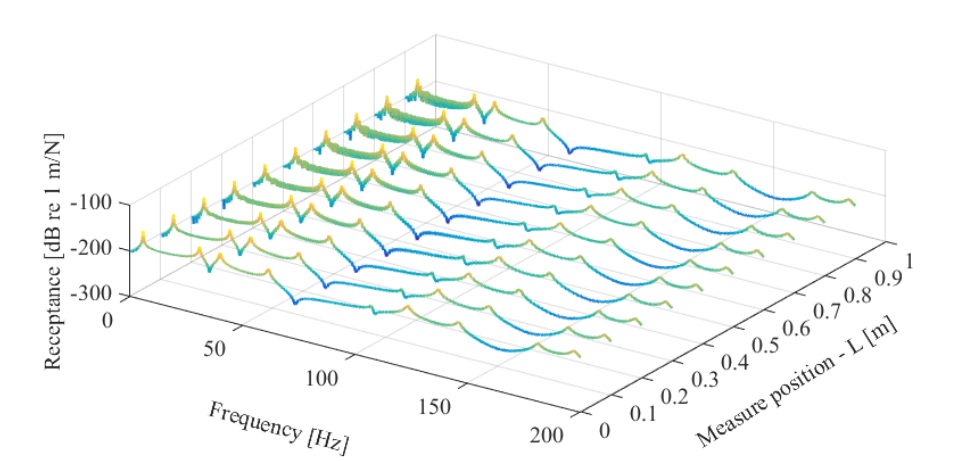
Figure 15. Cable’s receptances obtained from the coupling point (c) to 1 m (d) for every 0.1 m distance. The excitation point was assumed at point (c).